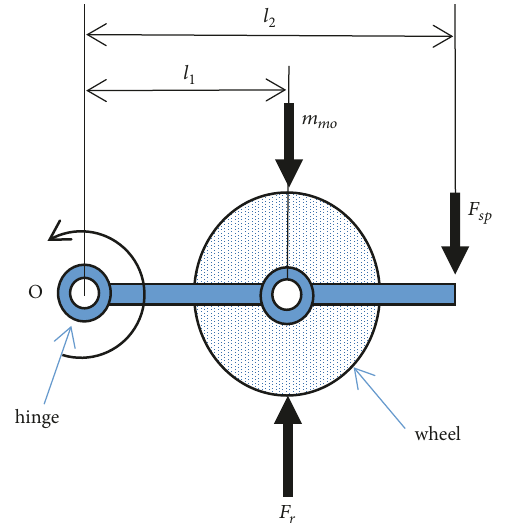
Figure 4: Free body diagram of a compliant wheel